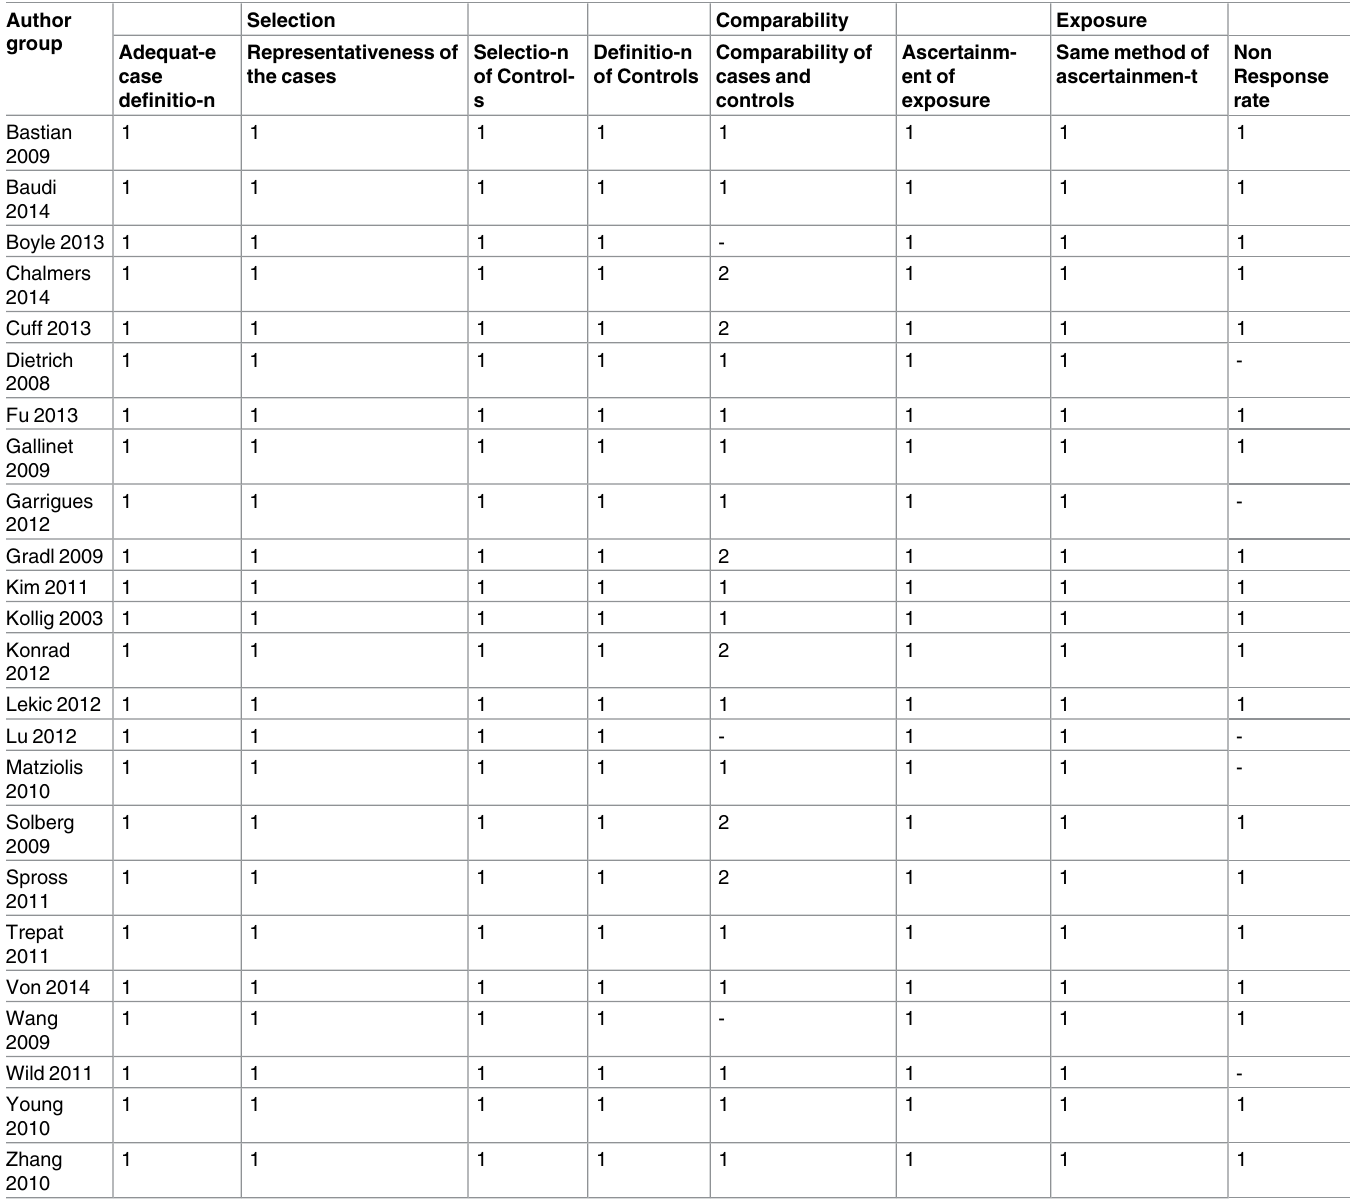
Table 2. Quality assessment of case—control studies comparing different treatments for displaced proximal humeral fracture using Newcastle— Ottawa